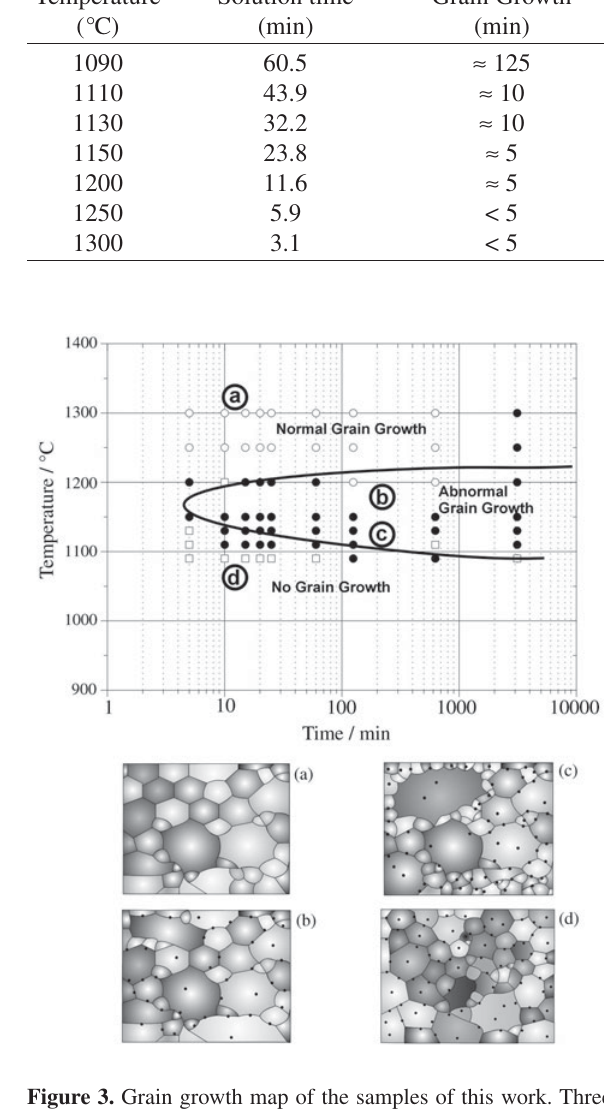
Figure 3. Grain growth map of the samples of this work. Three distinct behaviours can be seen: normal grain growth inhibition ( (cid:1) ), abnormal grain growth ( (cid:2) ) and normal grain growth ( (cid:3) ).